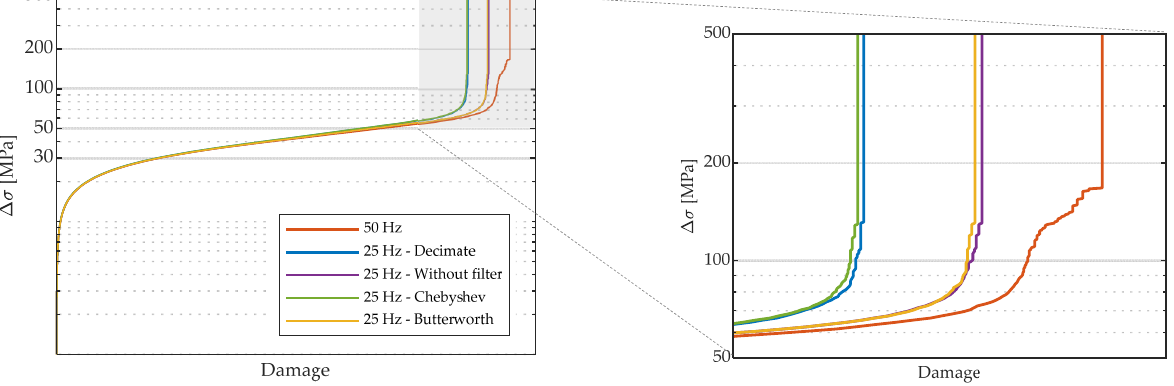
Figure 15. Influence of signal sampling frequency. Stress cycles as a function of the accumulated damage for a sampling frequency of 25 Hz, with zoom (x scale omitted because of confidentiality agreements).